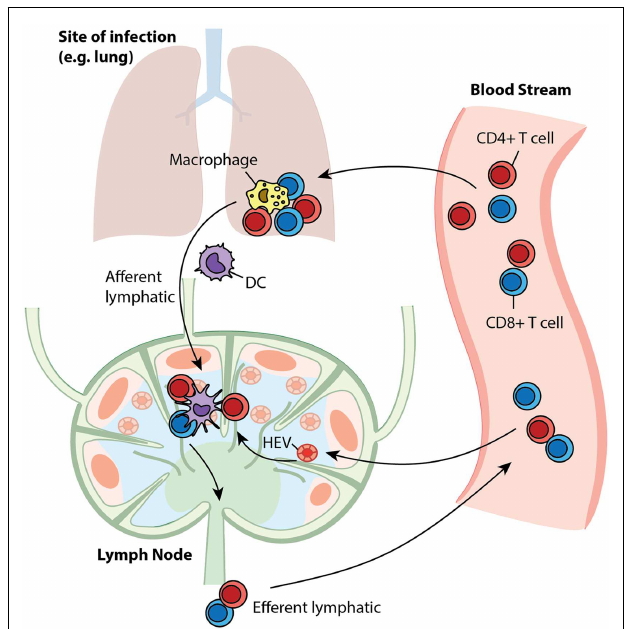
FIGURE 1 |T cell trafficking between compartments . NaïveT cells circulate between LNs and blood. Upon infection, APCs present antigen to cognateT cells in LNs to initiate their proliferation and differentiation to generate effector and memory cells. After entering the blood, effector cells are recruited to sites to fight ongoing infection, while memory cells recirculate, awaiting secondary